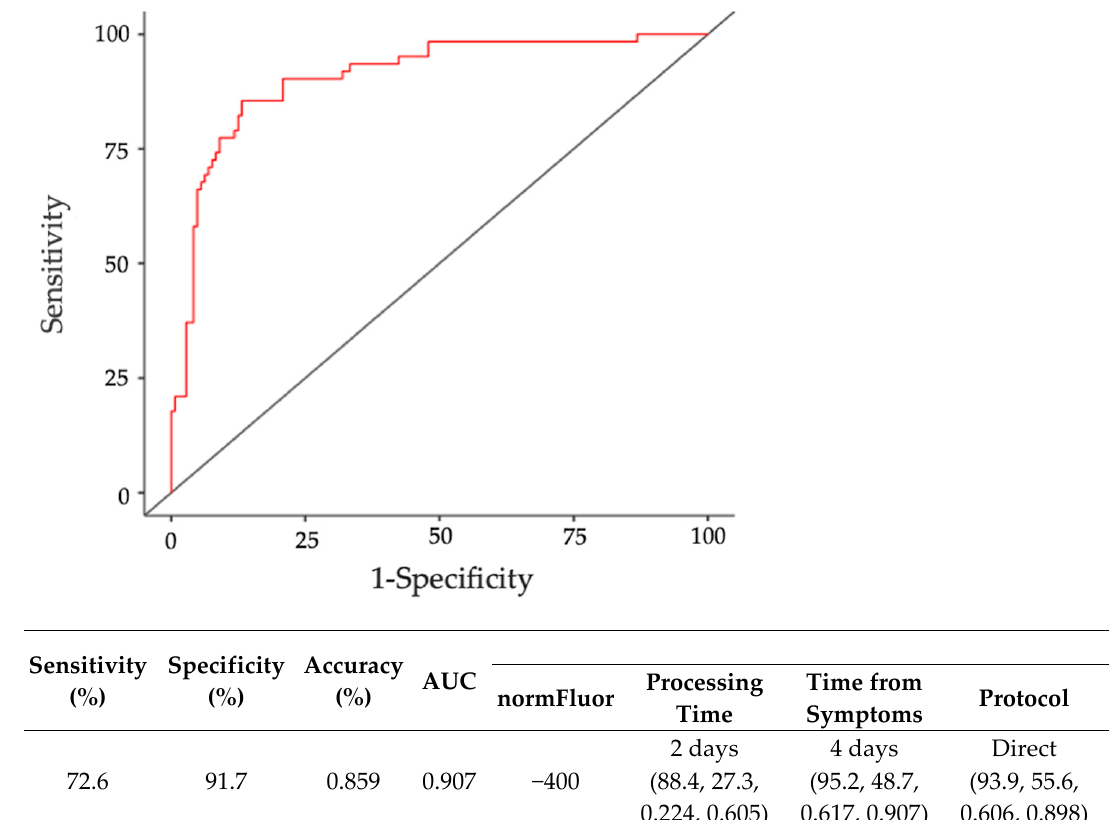
( b ) Figure 6. Estimated marginal means plots for ( a ) time from symptoms onset and ( b ) time for sample processing. Based on previous observations, optimal cutoff points for aptamer performance were obtained from a recalculated ROC curve (Figure 7) using normalized fluorescence, symp ‐ toms onset and processing times as covariates; and protocol/sample types as factors. Fig ‐